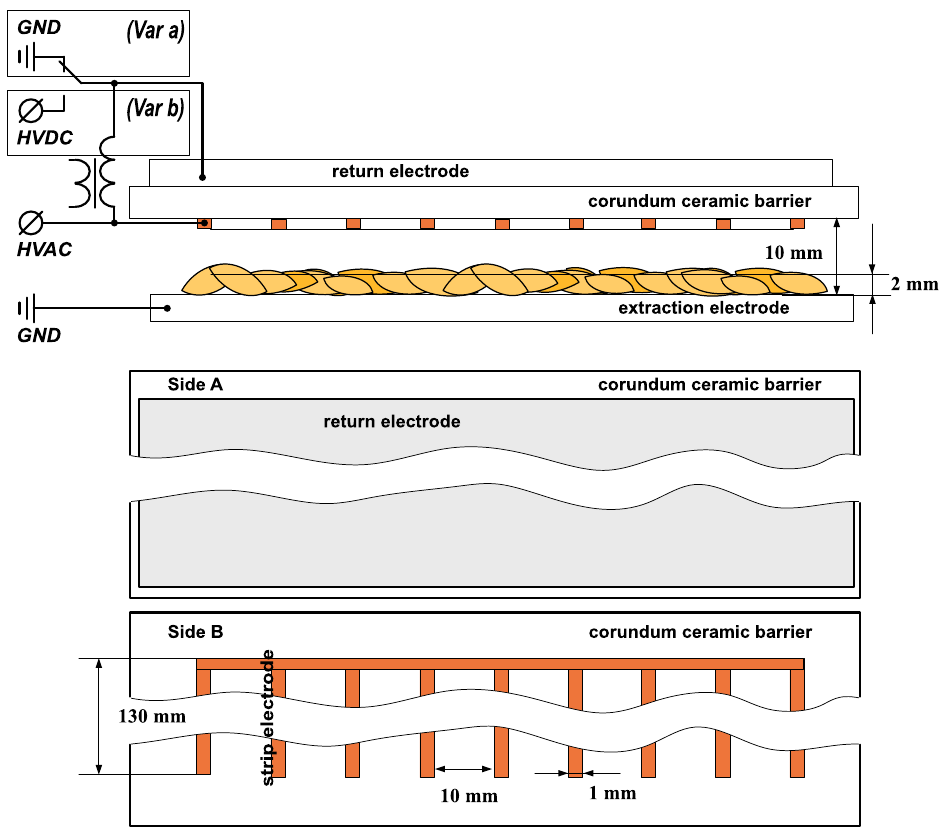
Figure 5. Electrode configuration scheme showing the surface dielectric-barrier discharge reactor. ( Var a ) The return electrode is grounded. ( Var b ) The return electrode is at the constant bias voltage of + 5 kV.